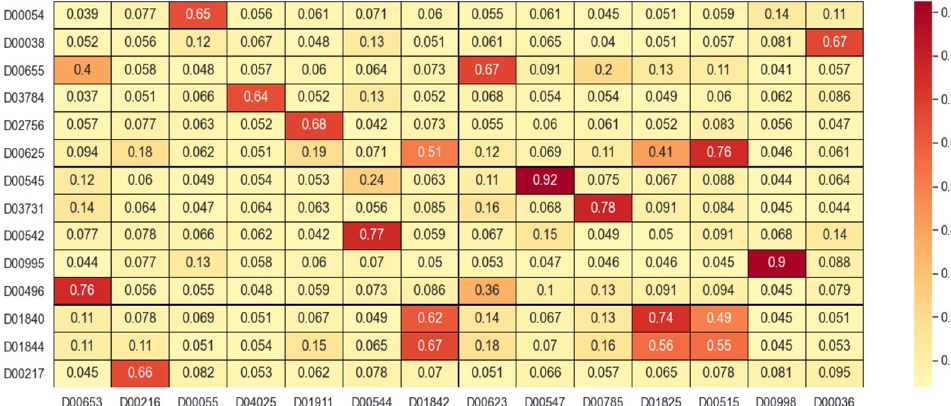
Figure 2. Partial results of similarity